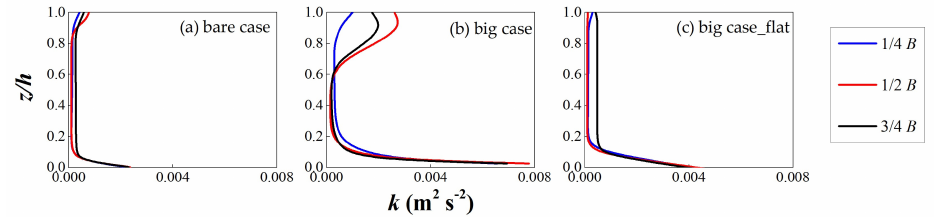
Figure 11. The distributions of TKE ( k ) at the 90 ◦ section for three